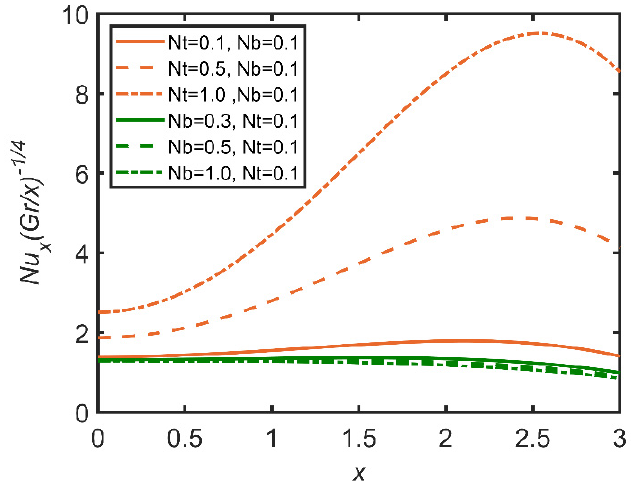
Figure 4. Comparison for Nusselt number against x.